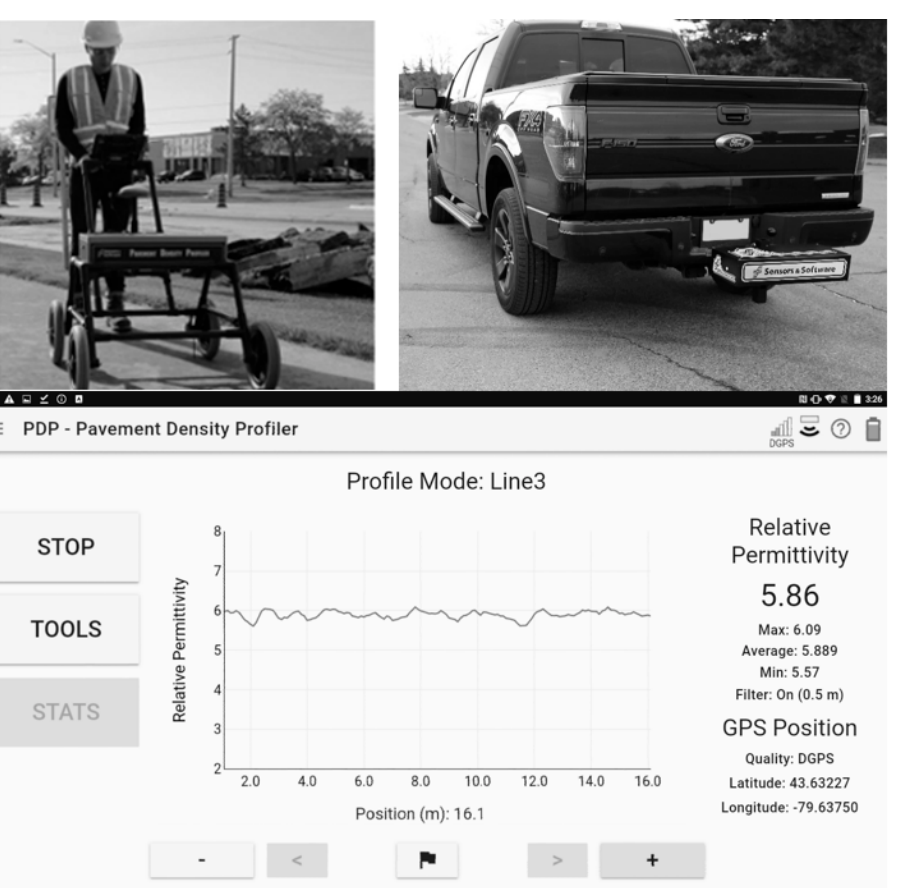
Figure 1. A cart-mounted ( top-left ) and a vehicle-based ( top-right ) PDP system. The bottom plot illustrates the PDP real-time display showing an output of the relative permittivity and its statis- tics.